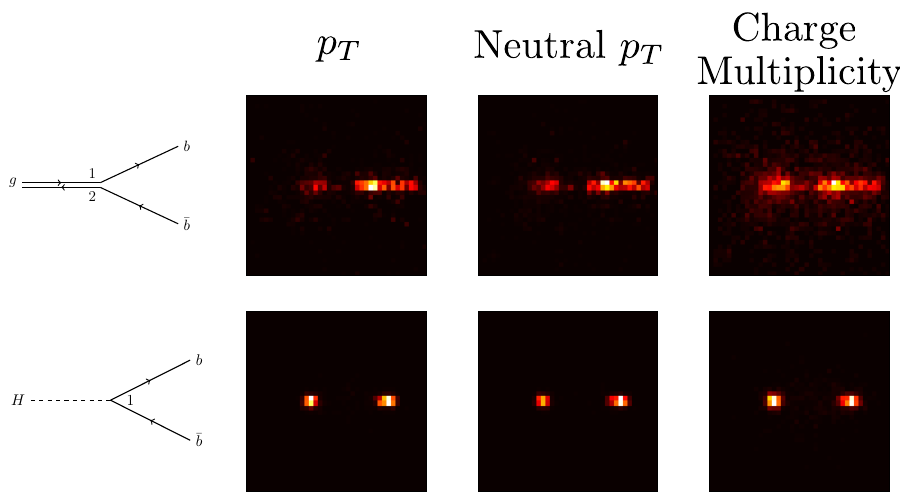
Figure 7 . Color flow for H ! b ¯ b and g ! b ¯ b , the main irreducible QCD background to our signal. The numbers 1 and 2 label di ff erent color lines. Figure 6 . Average jet images for the 100 most background like (top) and signal like (bottom) jets. The jet images are weighted by the p T in the (cid:12)rst column, the neutral p T in the second column, and the charge multiplicity in the third column. Due to the di(cid:11)erent color (cid:13)ows, the signal like